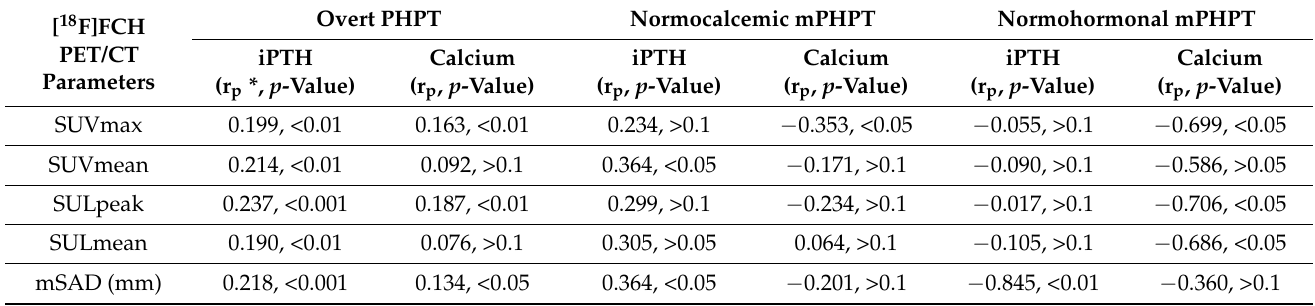
Table 3. Correlation between the semi-quantitative parameters of the index lesions on [ 18 F]FCH PET/CT and initial laboratory data.